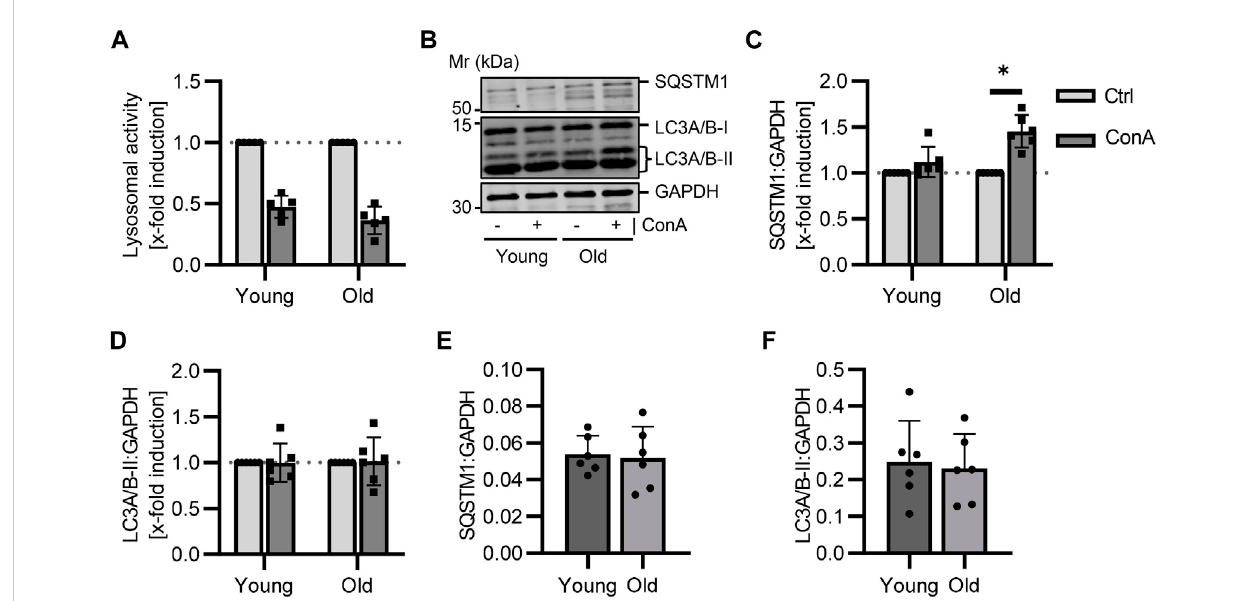
FIGURE 3 Aging affects the autophagy receptor SQSTM1 in murine PBMCs. Isolated PBMCs from young and old mice were treated with ConA for 2 h at 37 ° C ( n =5-6perage). (A) InhibitionoflysosomalactivitywasnotalteredbyageinmurinePBMCs (B) RepresentativewesternblotforSQSTM1,LC3A/B-I,LC3A/ B-IIandGAPDHincontrolandConAtreatedPBMCsfromyoung andoldmice. (C) SQSTM1toGAPDHturnoverwasincreasedinoldPBMCsduetoConA treatment, (D) while LC3A/B-II to GAPDH was not affected. (E) Control SQSTM1 and (F) LC3A/B-II protein levels murine PBMCs showed no aging effect. Data represent mean ± SD. Statistical signi fi cance was tested with one sample Wilcoxon test (A – D) or t -test (E, F) and given as follows: * p ≤ 0.05. Mr, molecular weight